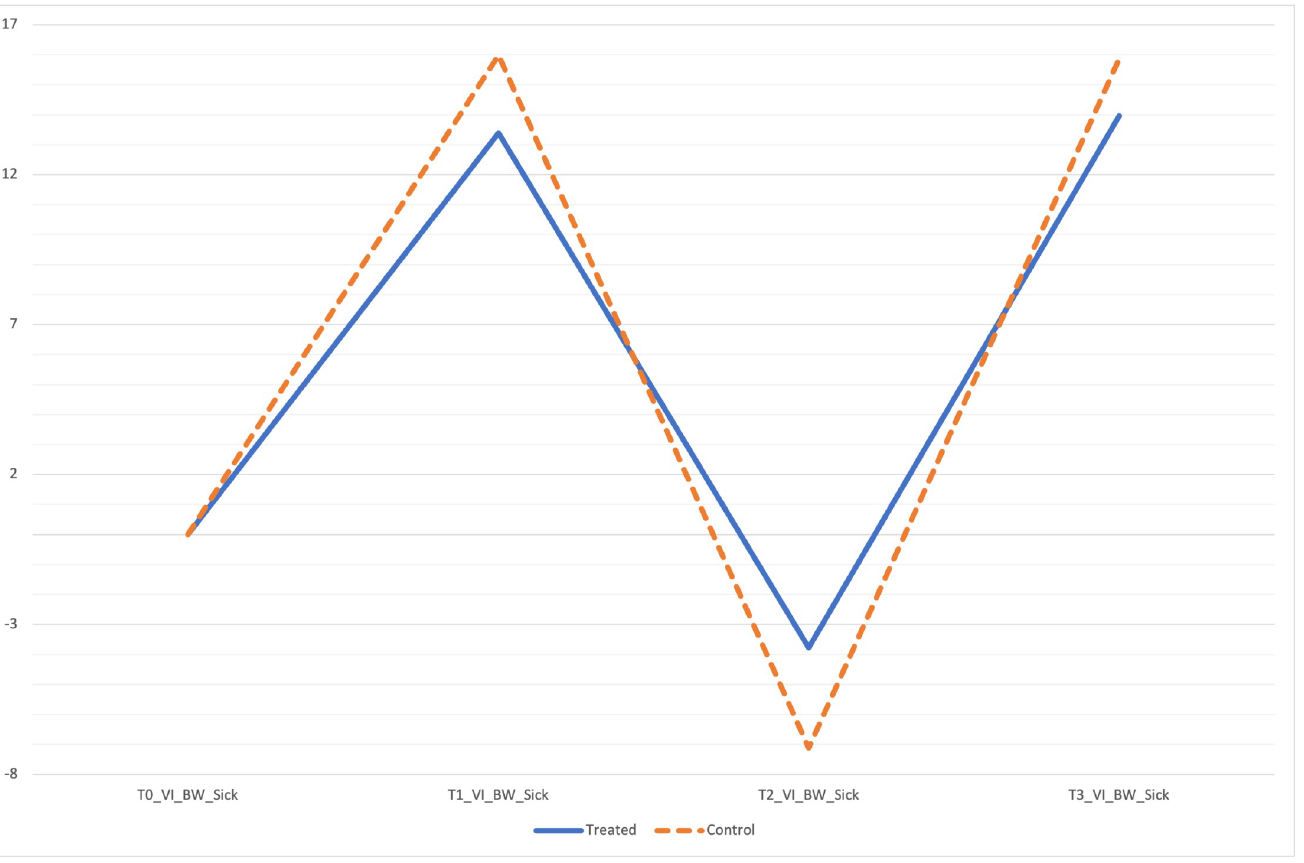
Fig 2. Percentage increase in VI%BW over time between two